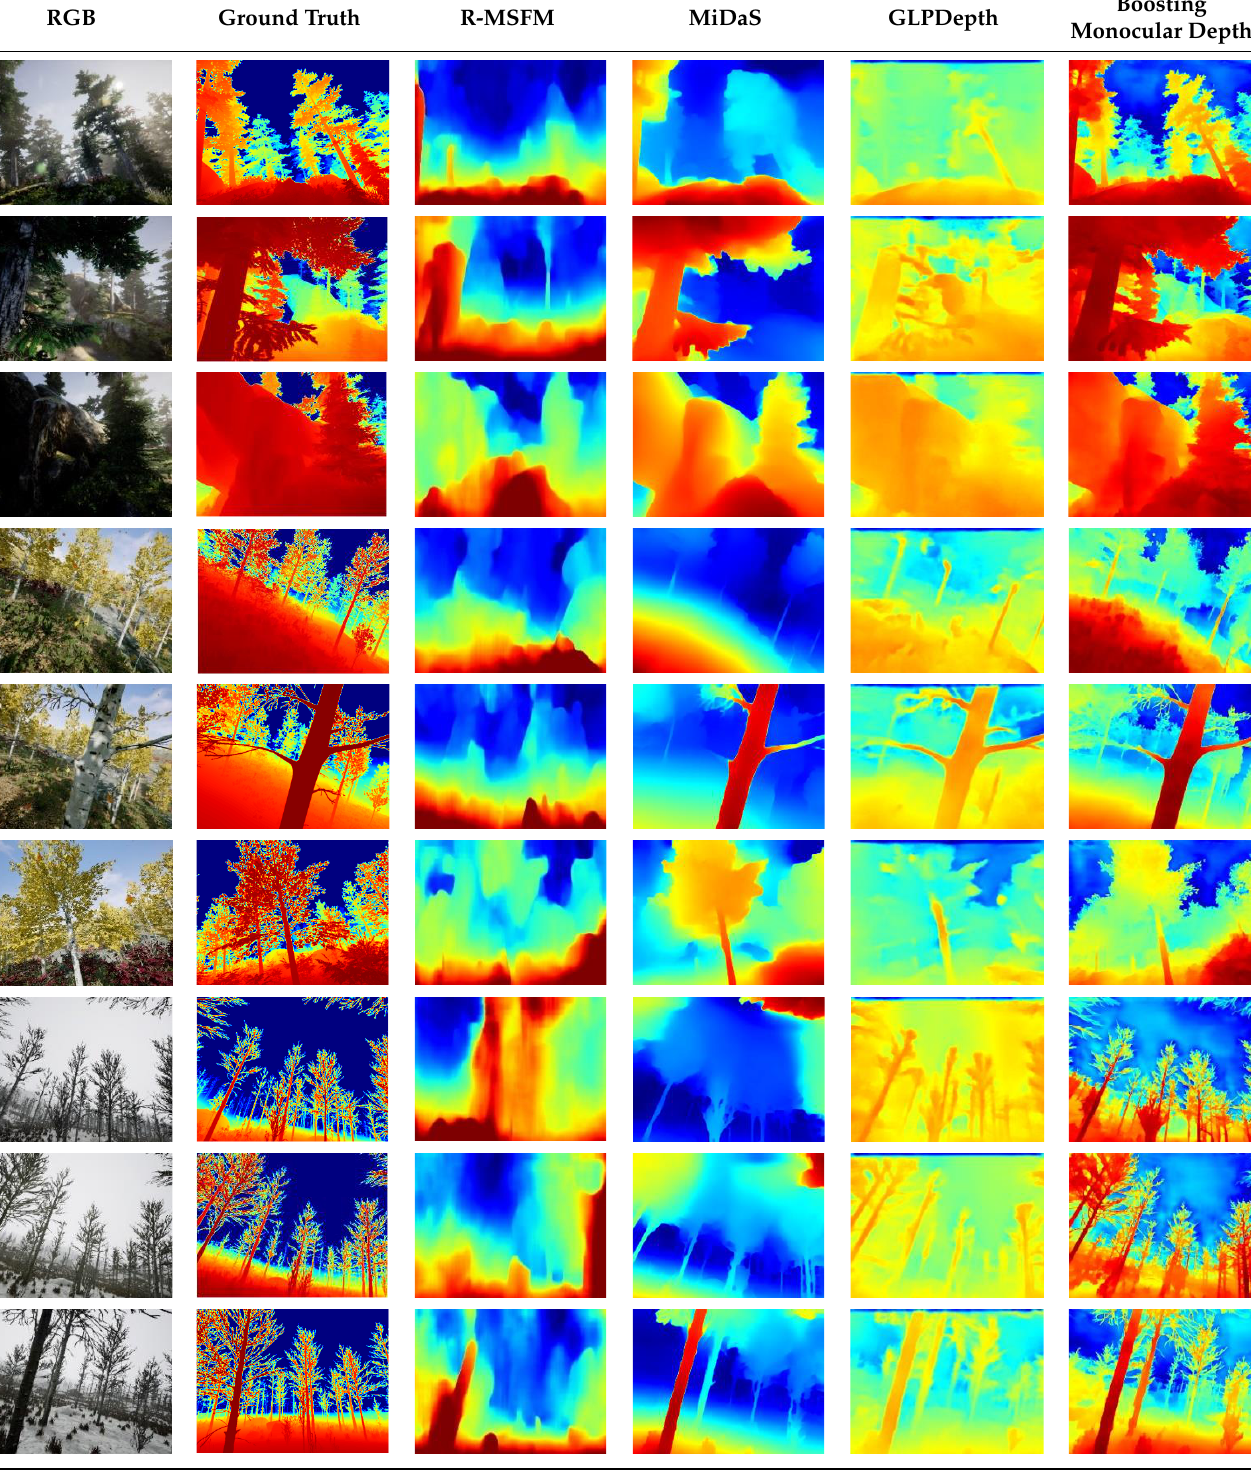
Table 4. Depth maps of forested environments generated from state-of-the-art monocular depth networks.